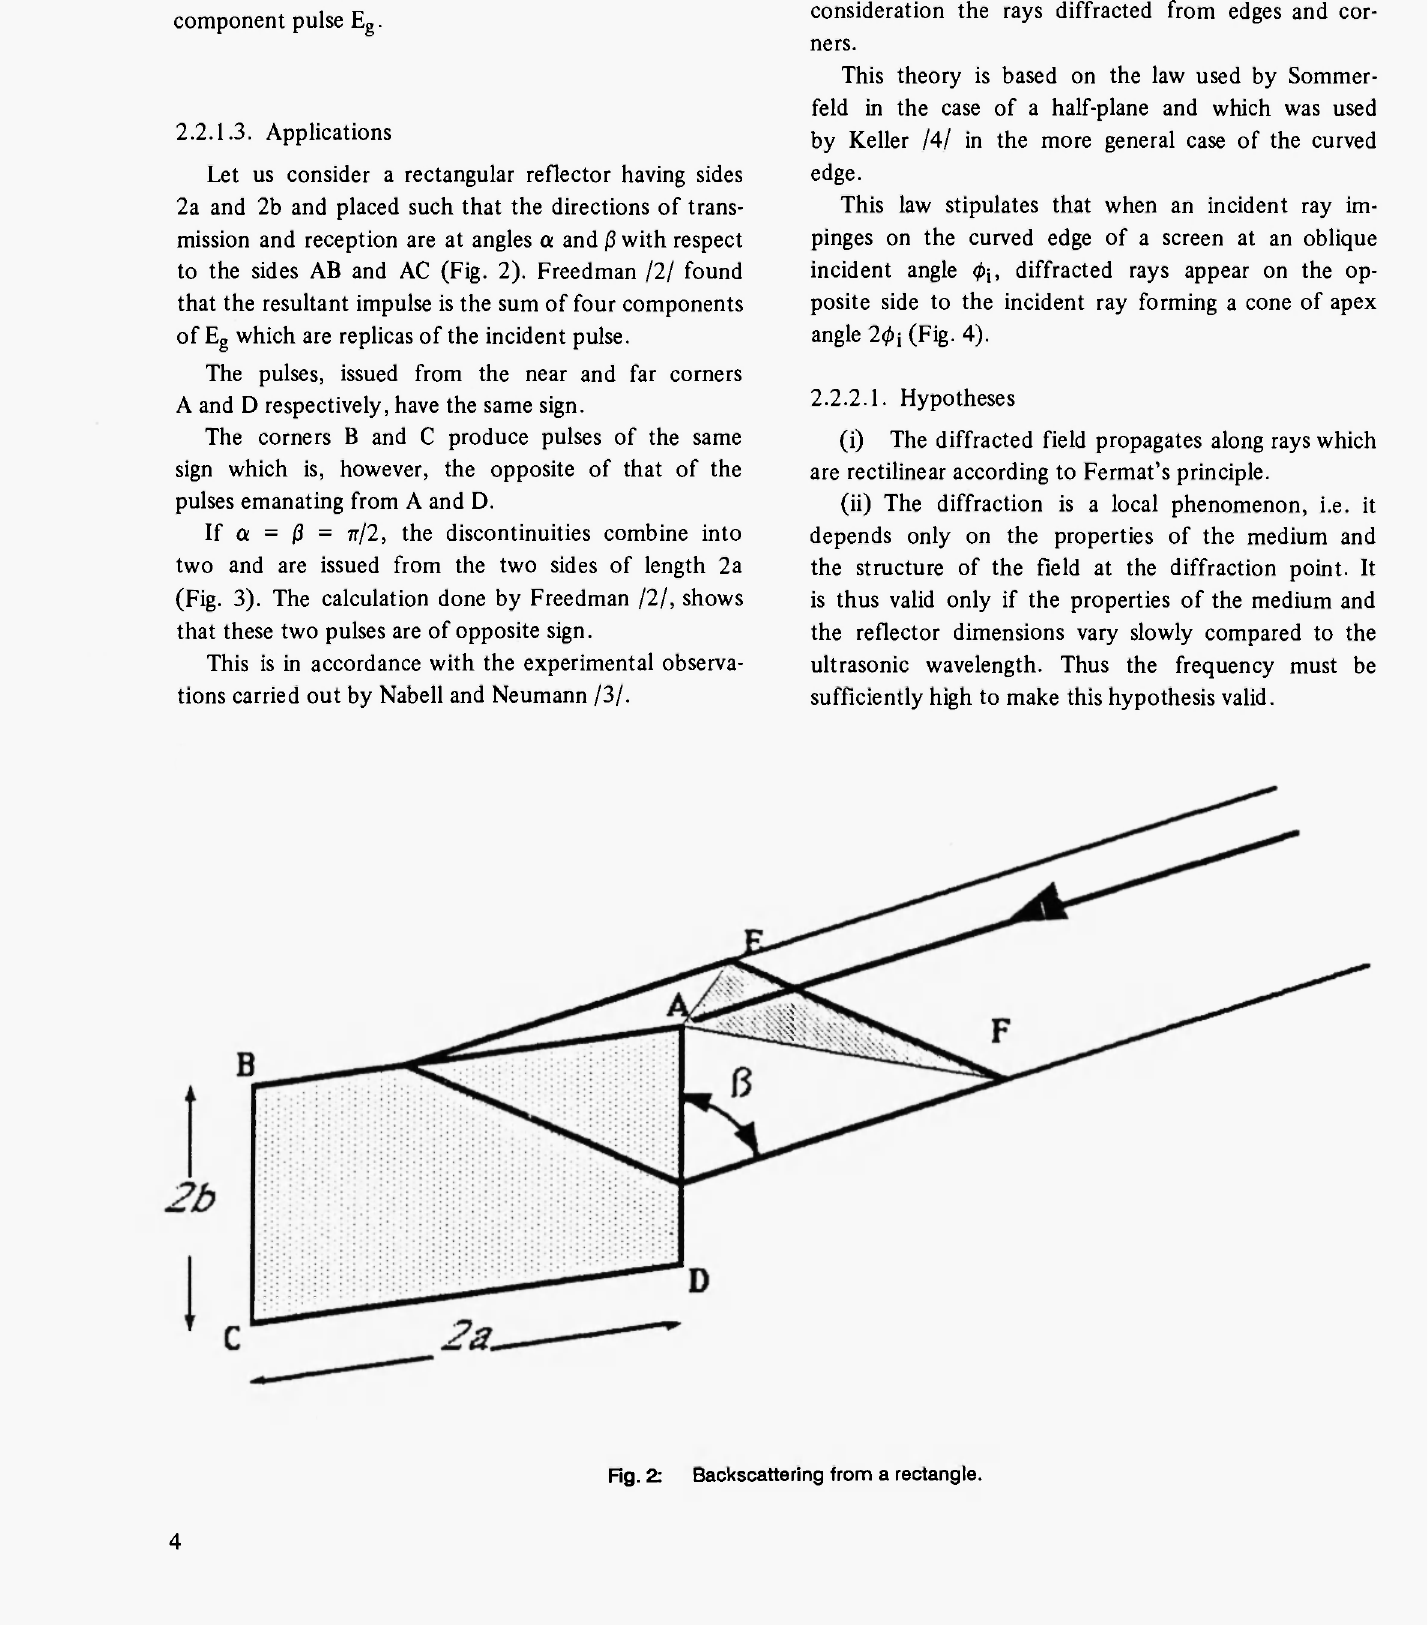
Fig. 2: Backscattering from a